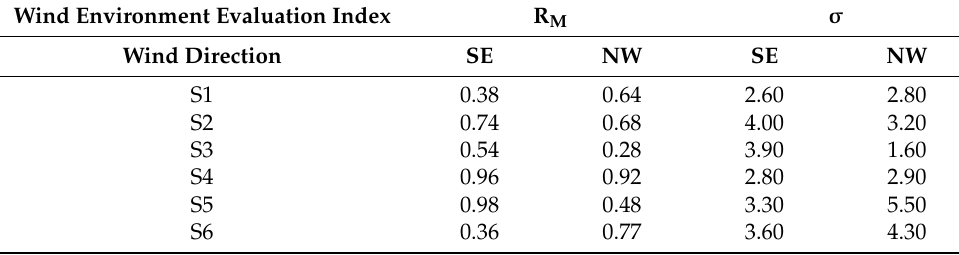
Table 10. Average wind speed ratio and wind speed dispersion at different wind directions for skyline rhythm index.